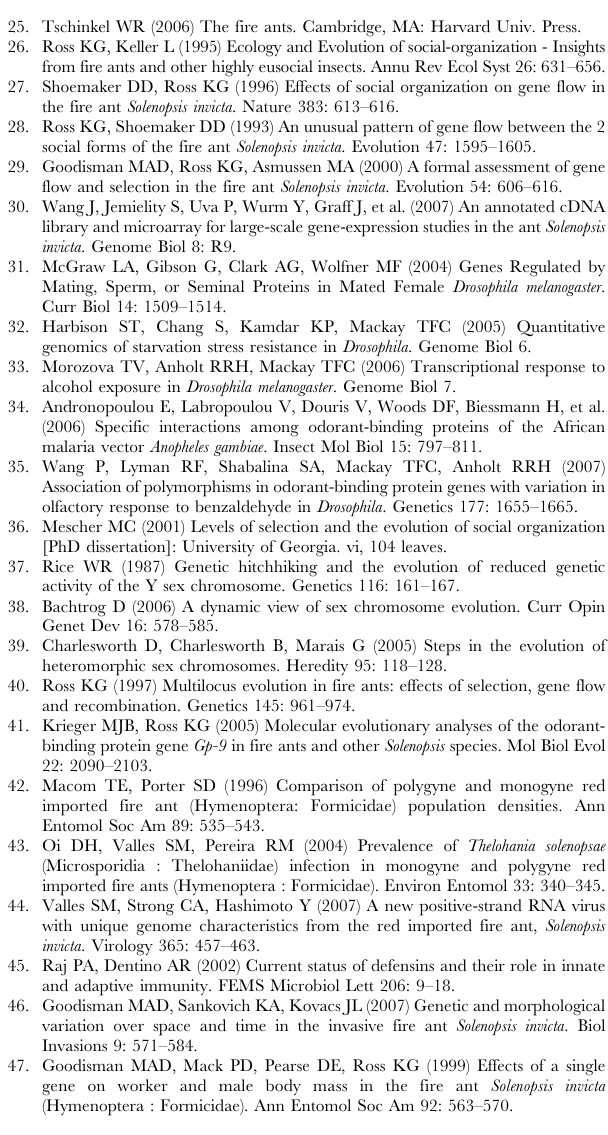
Table S1 Comparison of qRT-PCR and microarray expression ratios. Table S2 List of gene categories significantly overrepresented among differentially expressed genes in the genotype and social form comparisons. Table S3 BLASTX matches for genes differentially expressed between polygyne Gp-9 BB and Gp-9 Bb workers.